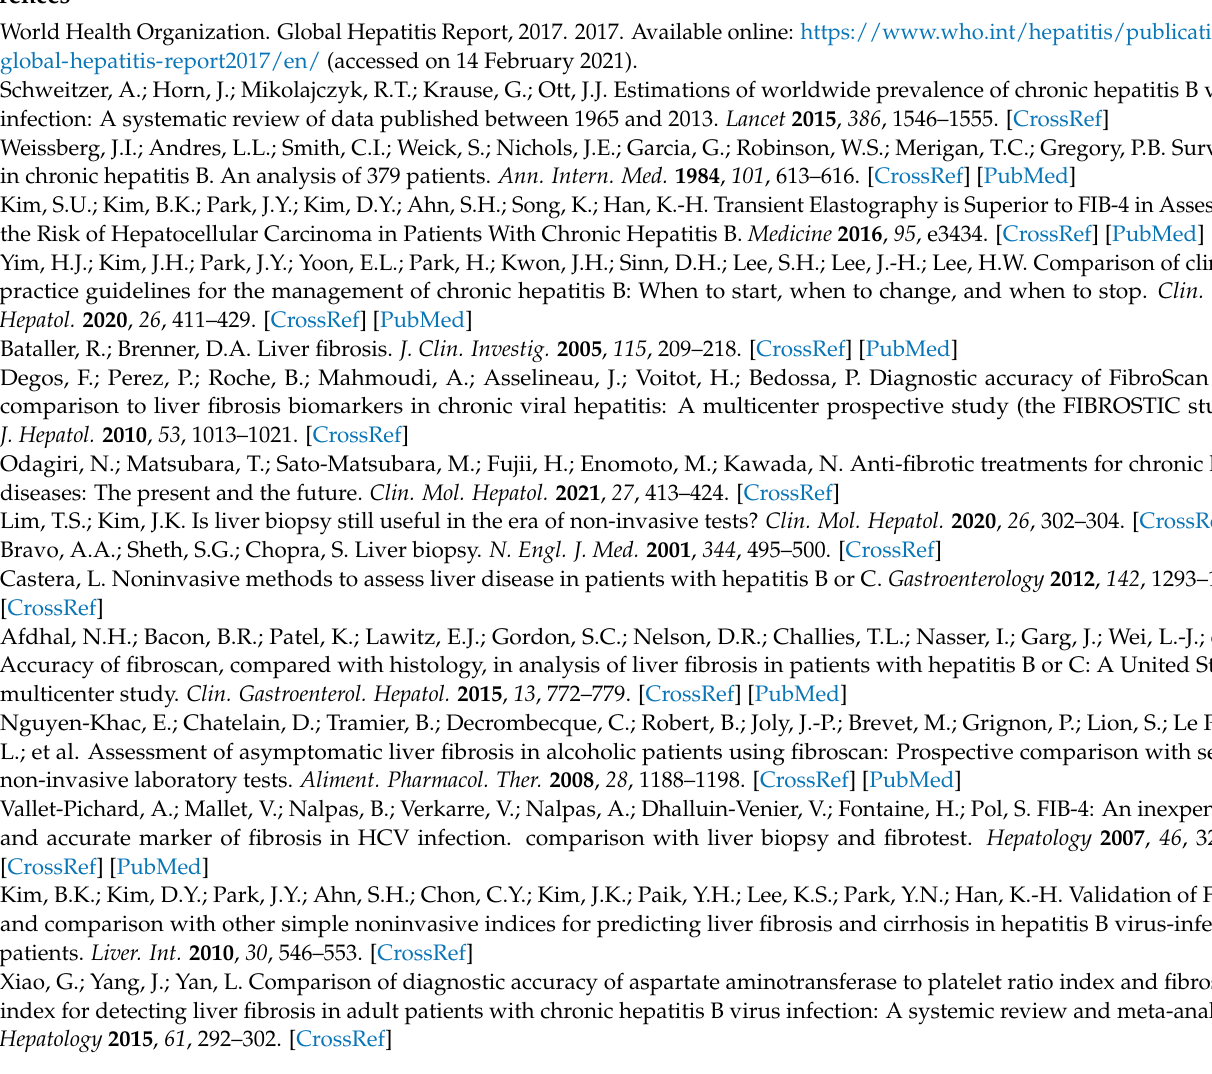
C, patients with CHB F3 versus healthy controls. Figure S2: The AUROC of serum AsAGP levels for differentiating advanced fibrosis (F ≥ 3) in CHB patients compared to that in healthy controls. Table S1: Diagnostic performance of serum AsAGP levels according to fibrosis stage in CHB patients compared to that in healthy